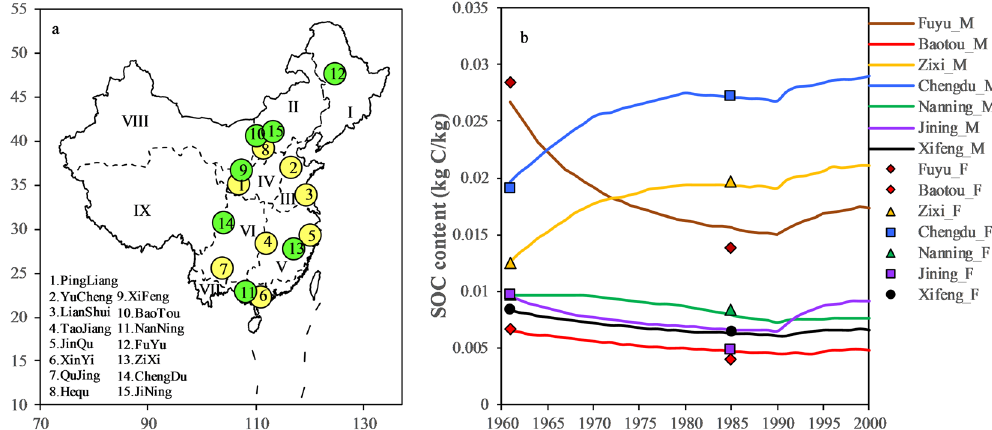
Figure 5. Long-term SOC validation of DNDC in China. The dots of the figure on the right represent field data from the two national soil surveys in China in the 1960s and 1980s. The line represents the simulation results. Sites 1 to 8 in the figure on the left are from Zhang et al . (2006, 2015). The figure was generated using Microsoft excel 2016 software provided by Microsoft